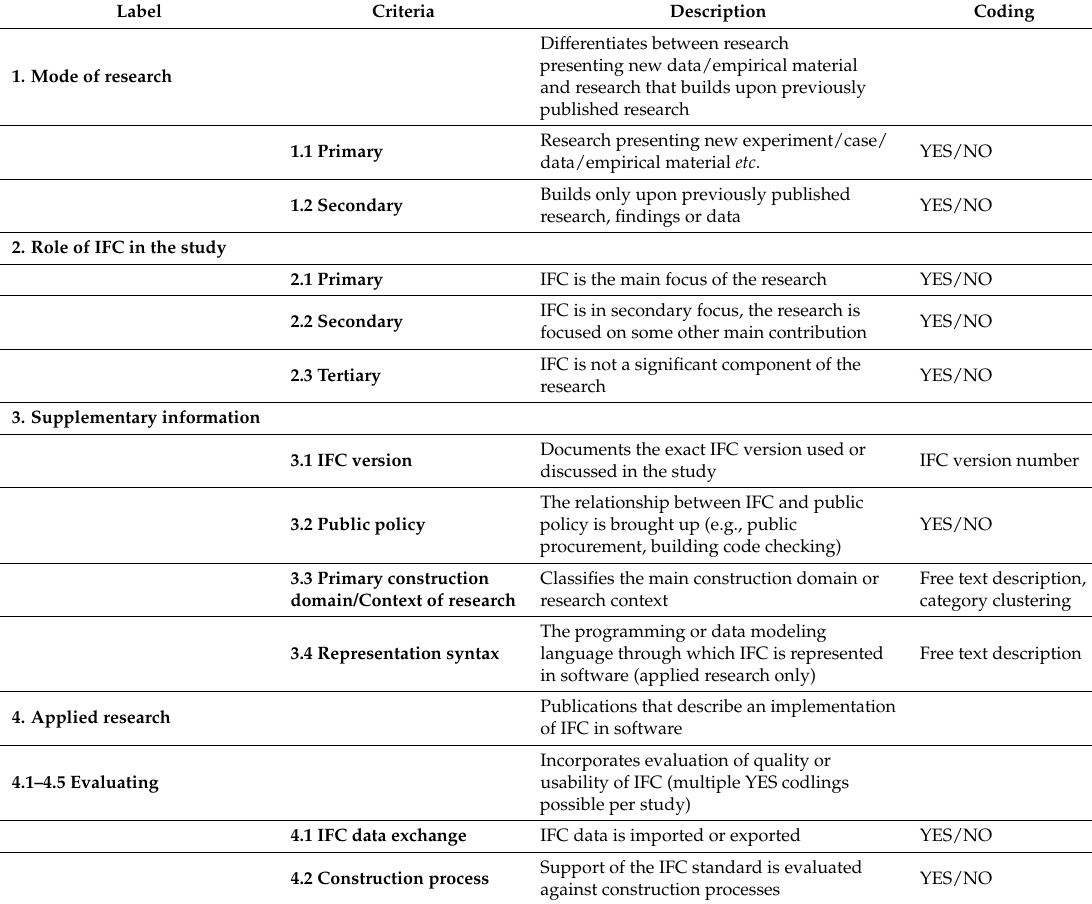
Table 1. Literature mapping